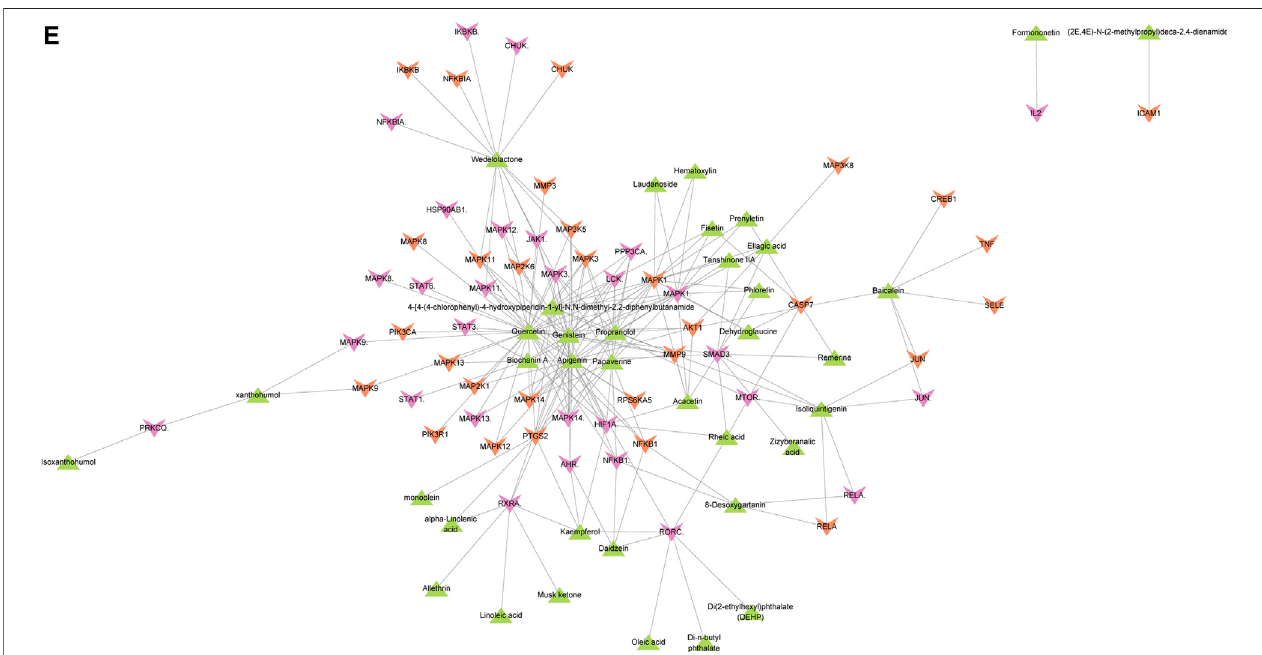
FIGURE2| Networkanalysisoftherelationship betweenMMQ-8active metabolites, obesity, andin fl ammation. (A) Venn diagramshows therelationshipbetween target genes of MMQ-8 active metabolites, obesity-related genes, and in fl ammation-related genes. We identi fi ed 225 target genes related to each group. (B) The interaction between these 225 target genes and MMQ-8 active metabolites (the colors of the nodes represent different roles: green for active metabolites, and pink for target genes). (C) GO enrichment of the 225 target genes (top 10 of pathway enrichment in each part of BP: Biological Process; CC: Cellular Components; MF: Molecular Function). (D) KEGG enrichment of the 225 target genes (top 20 of pathway enrichment). The KEGG pathways of interest are marked in a red box. (E) The interaction between MMQ-8 active metabolites and the target genes of the TNF signaling pathway, Th1 and Th2 cell differentiation, and Th17 cell differentiation (the colorsofthenodesrepresentdifferentroles:greenforactivemetabolites,orangeyellowfortargetgenesofTNFsignalingpathway,andpinkfortargetgenesofTh1,Th2, and Th17 cell